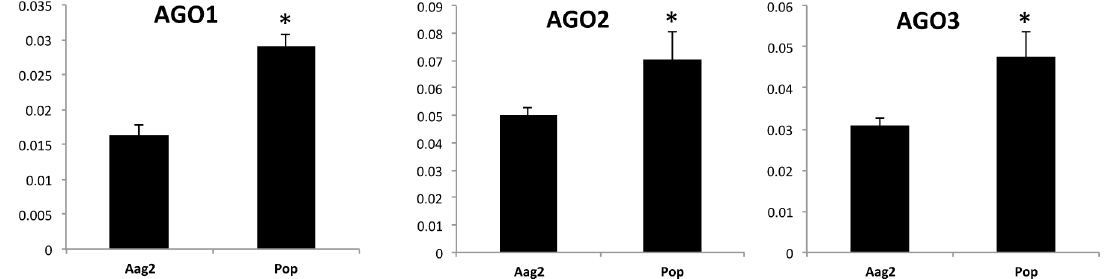
Figure 6. RT-qPCR analysis of mRNA transcript levels of Argonaute 1–3 (AGO1–3) in Aag2 and Pop cells. For each sample, three biological replicates with three technical replicates were analyzed (* p ,